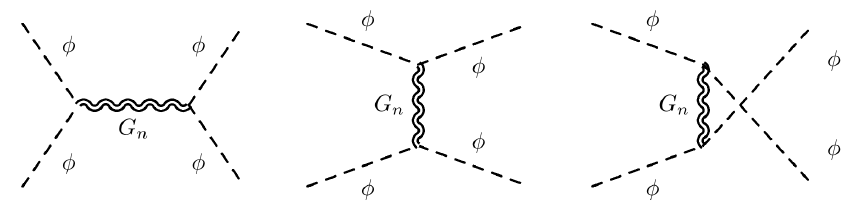
Figure 8 . Diagrams contributing to elastic scattering of scalar fields through G n , φφ G n −→ φφ